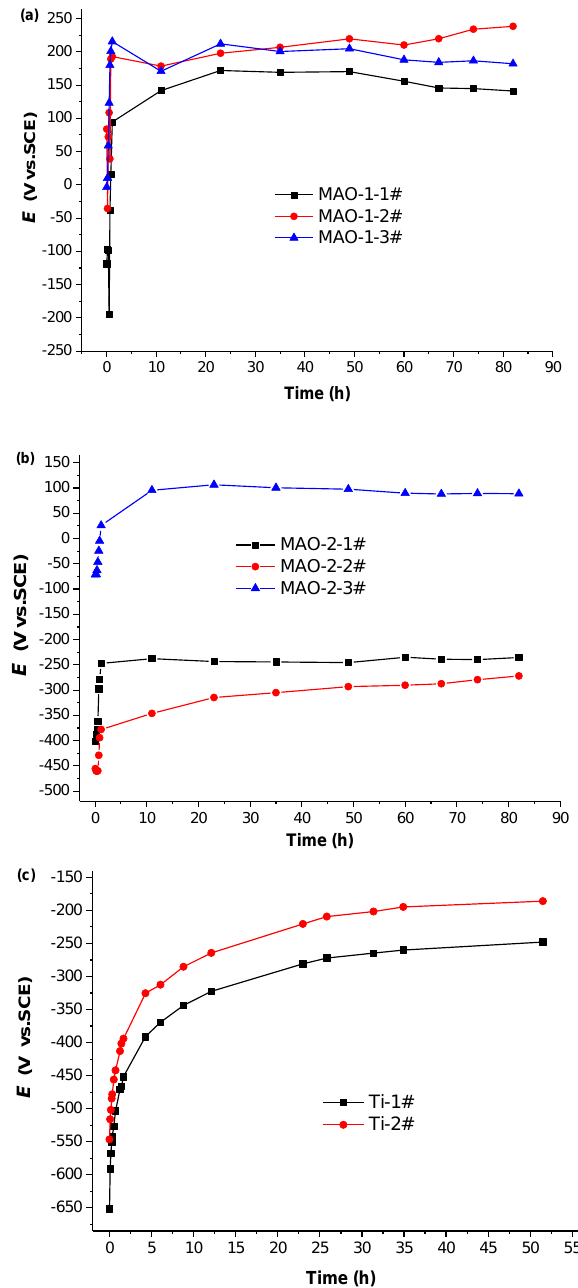
Figure 8. The changes of OCP with time for different coating specimen immersion in 3.5% NaCl solution: ( a ) MAO-1, ( b ) MAO-2, and ( c ) bare TA2.